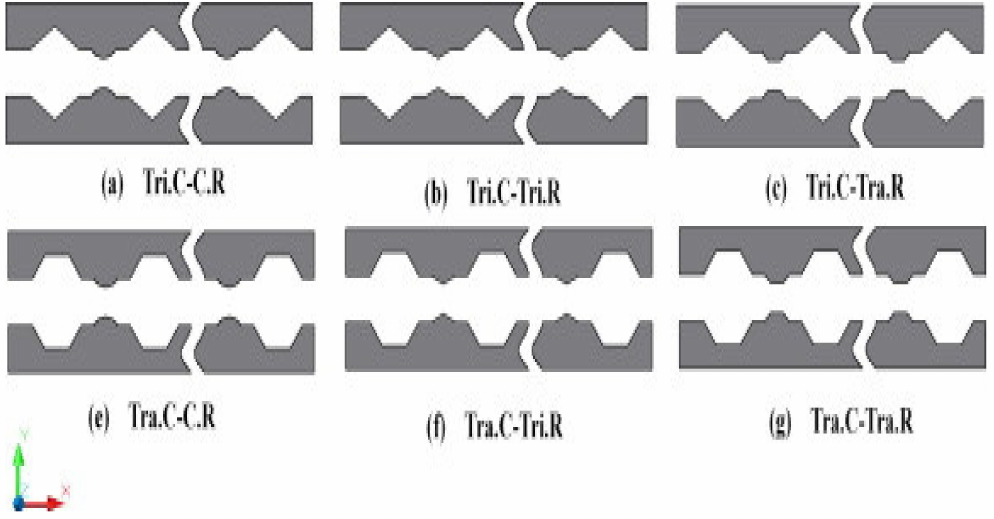
Figure 8. Square channel with different ribs and cavities, ( a ) (Tri.C-C.R), ( b ) (Tri.C–Tri.R), ( c ) (Tri.C– Tra.R), ( e ) (Tra.C-C.R), ( f ) (Tra.C-Tri.R), ( g ) (Tra.C- Tra.R) [86] © Elsevier, 2015.